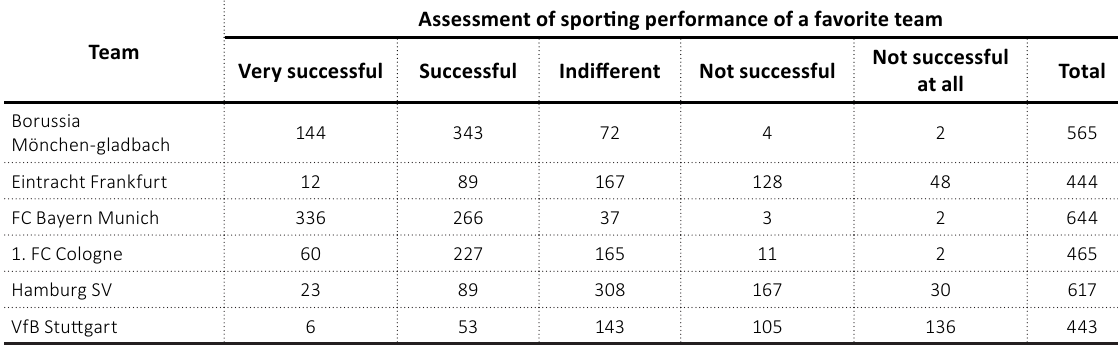
Table 10. Assessment of sporting performance differentiated by teams